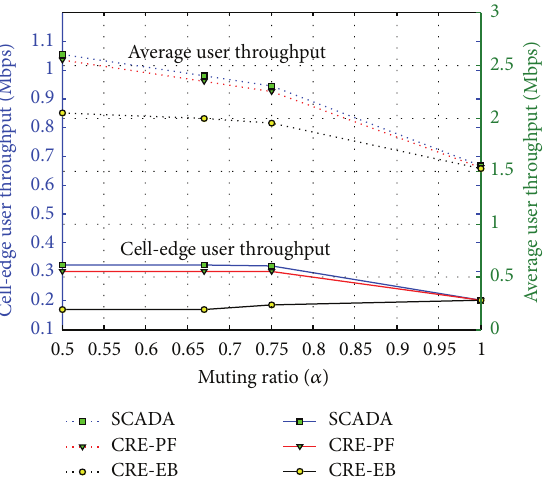
Figure 11: Throughput performance of the ACCRE algorithm